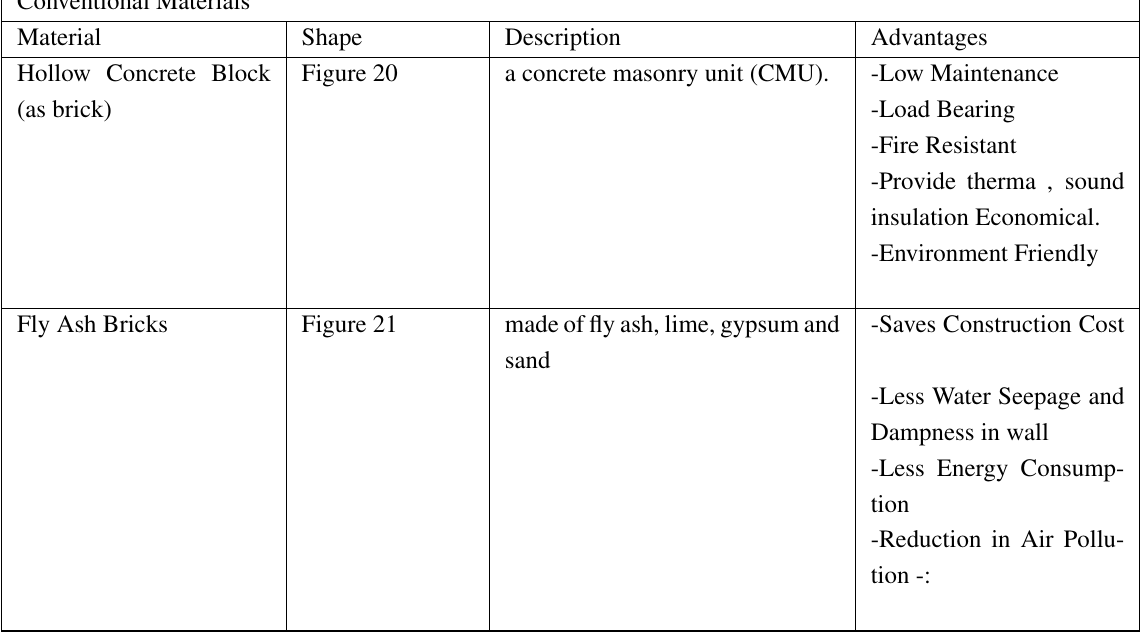
Table 4. Conventional Materials